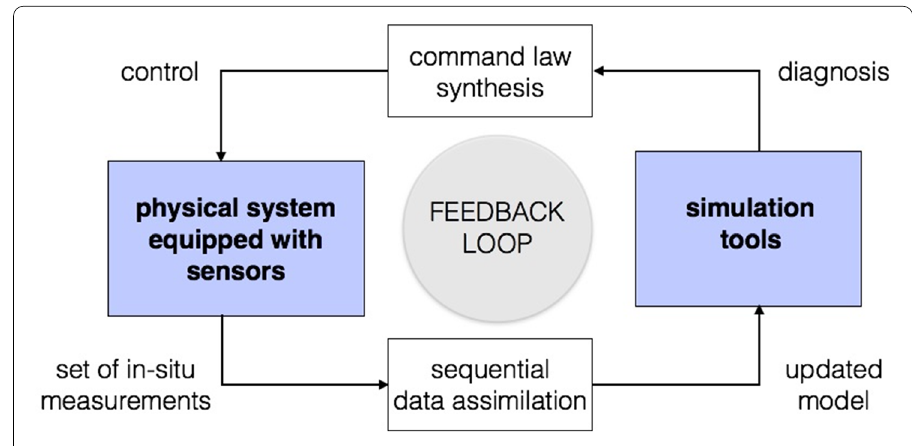
Fig. 1 Scheme of the DDDAS feedback control